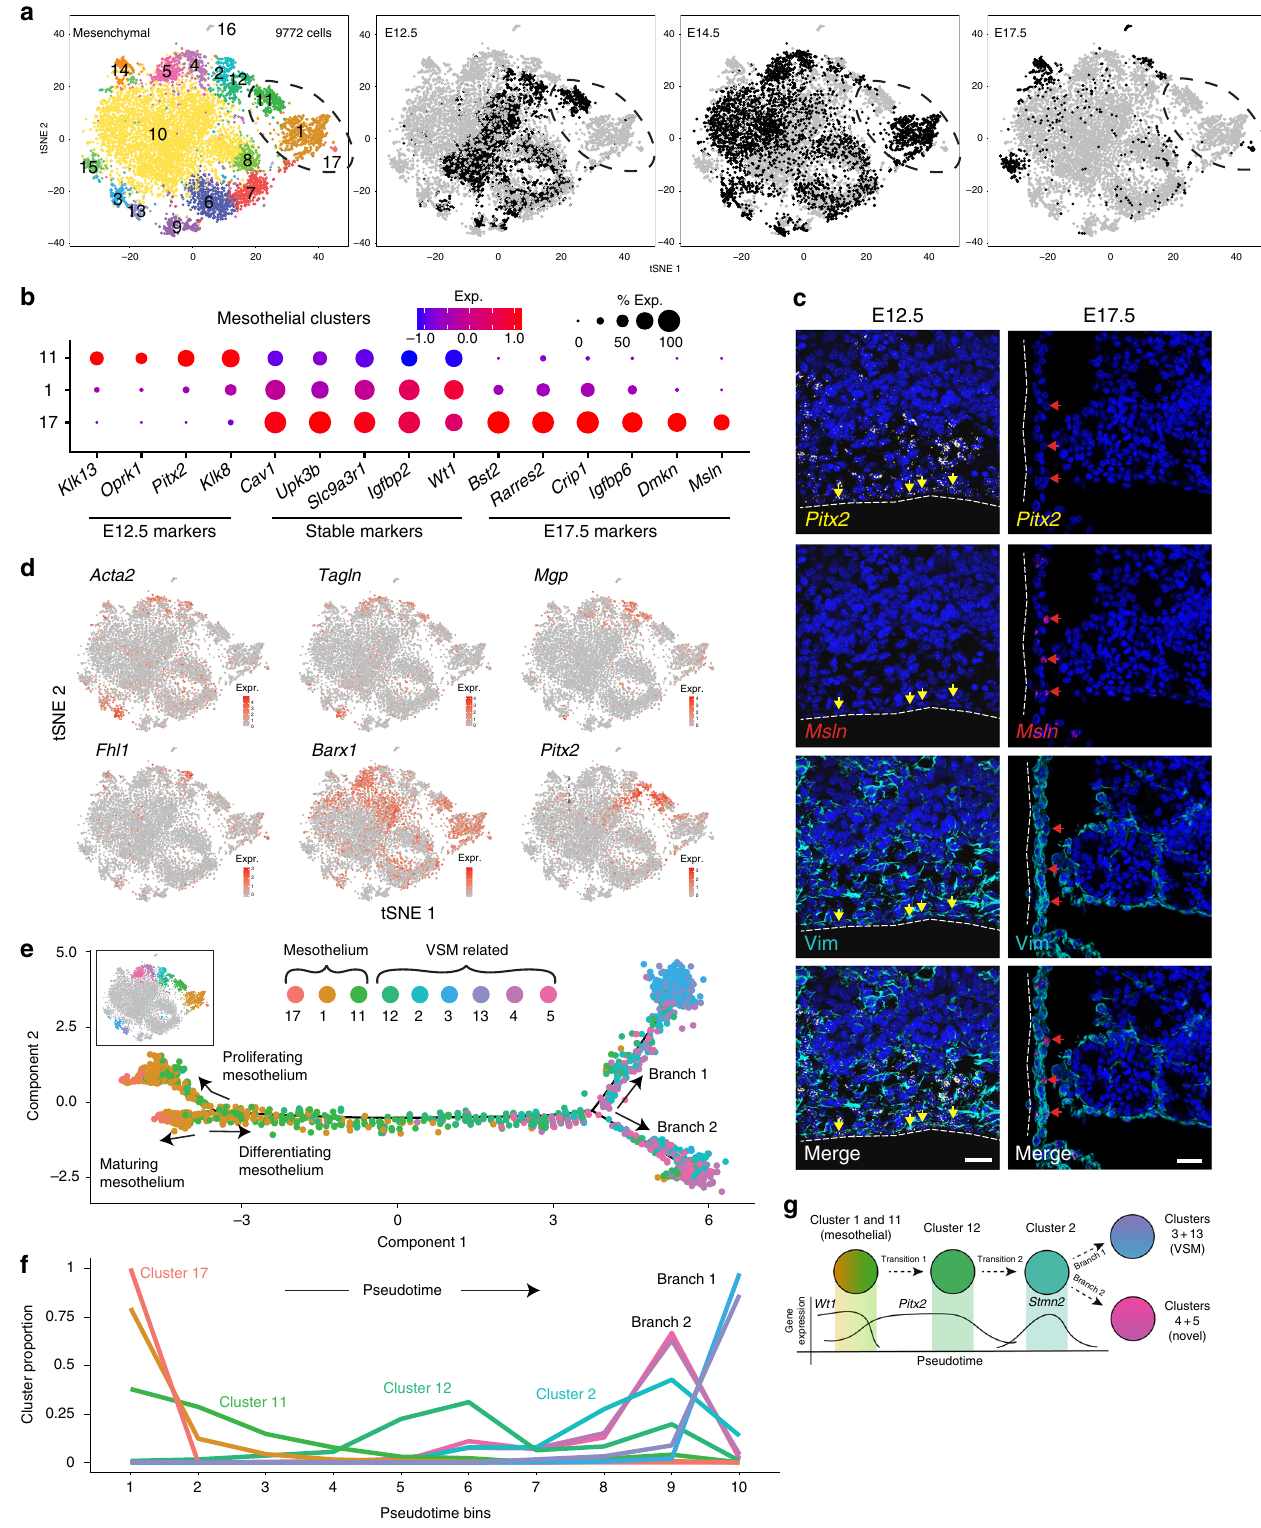
closer in pseudotime to the Ngn3 + population and was followed To validate these lineage relationships, we performed an in vivo by the Fev Hi /Chgb + population (Fig. 4g), indicating that the lineage trace of Ngn3 + cells. In E14.5 Ngn3-Cre; ROSA26 mTmG former represents an earlier cell state. Unlike alpha and beta cells, mouse pancreata, where lineage-traced cells are membrane-green fl uorescent protein (GFP + ) 34 , approximately 20% of all Ngn3 - epsilon cells were found throughout the trajectory populated by the Fev + /Pax4 + and Fev Hi /Chgb + populations (Fig. 4g), lineage-traced cells were identi fi ed as the Fev Hi population by the possibly re fl ecting their function as multipotent progenitor cells presence of Fev and the absence of both Ngn3 and the pan- for alpha and gamma lineages during development 33 . differentiated endocrine cell marker Islet1 ( Isl1 ) (Fig. 5a, e, yellow NATURE COMMUNICATIONS| (2018) 9:3922 |DOI: